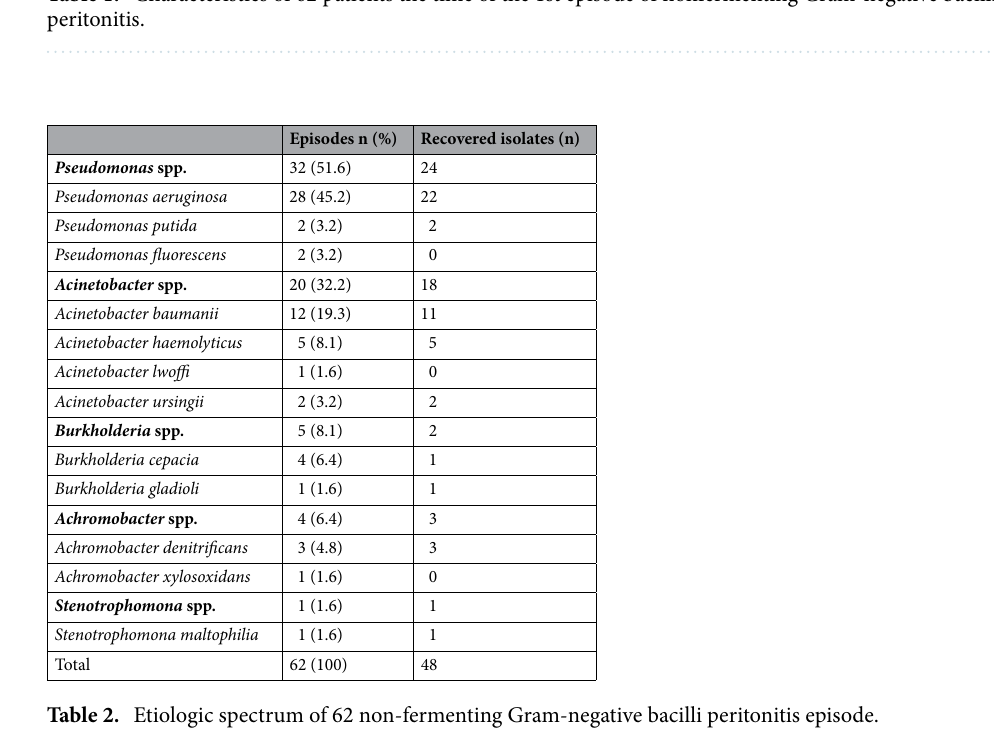
Table 2. Etiologic spectrum of 62 non-fermenting Gram-negative bacilli peritonitis episode.